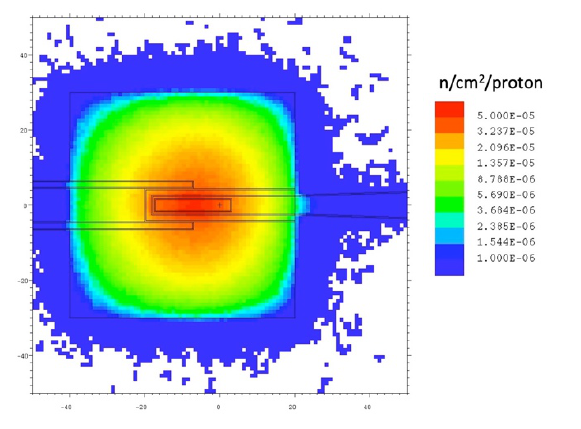
Fig. 4. Low energy ( E < 0.4 eV) neutron fluence map for the 2- target configuration.